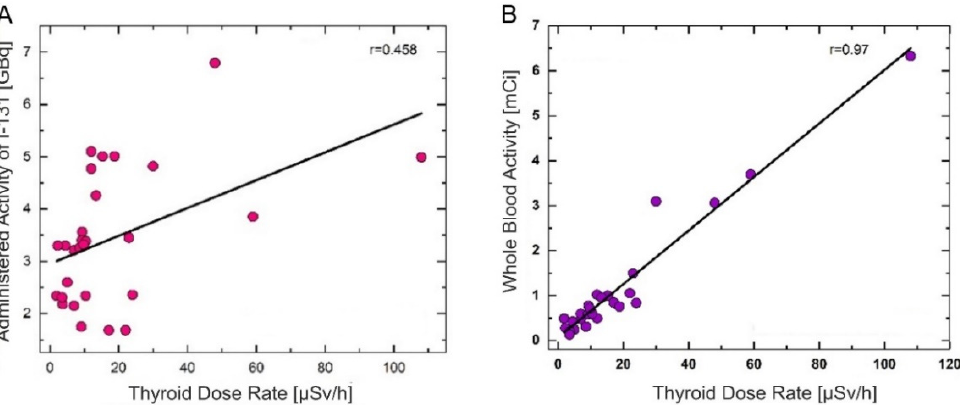
Figure 4. Correlation measured at 46 h between the dose rate at 1 m distance from the neck area and 131 I activity ( A ); correlation measured at 69 h between the dose rate at 1 m distance from the neck area and the whole blood activity ( B ).